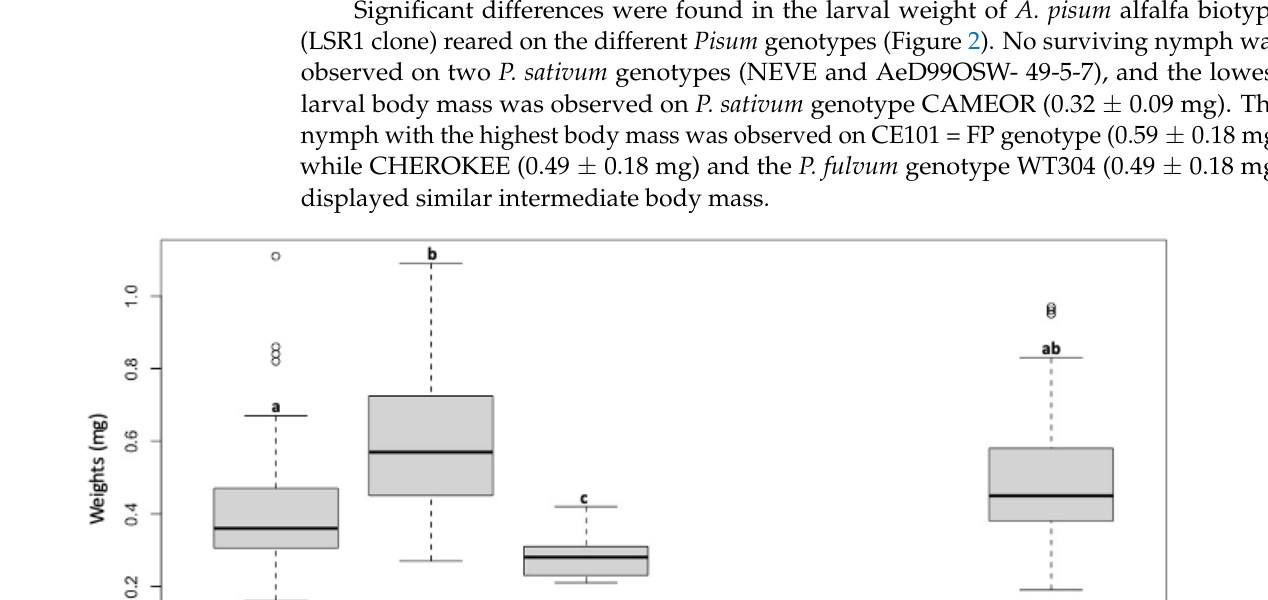
Figure 1. Larval body mass (8-day-old) of pea biotype, ArPo28, reared on different genotypes of P. sativum and on P. fulvum. Different letters indicate significant differences (one-way ANOVA, post- hoc comparisons using DGC, p < 0.05).